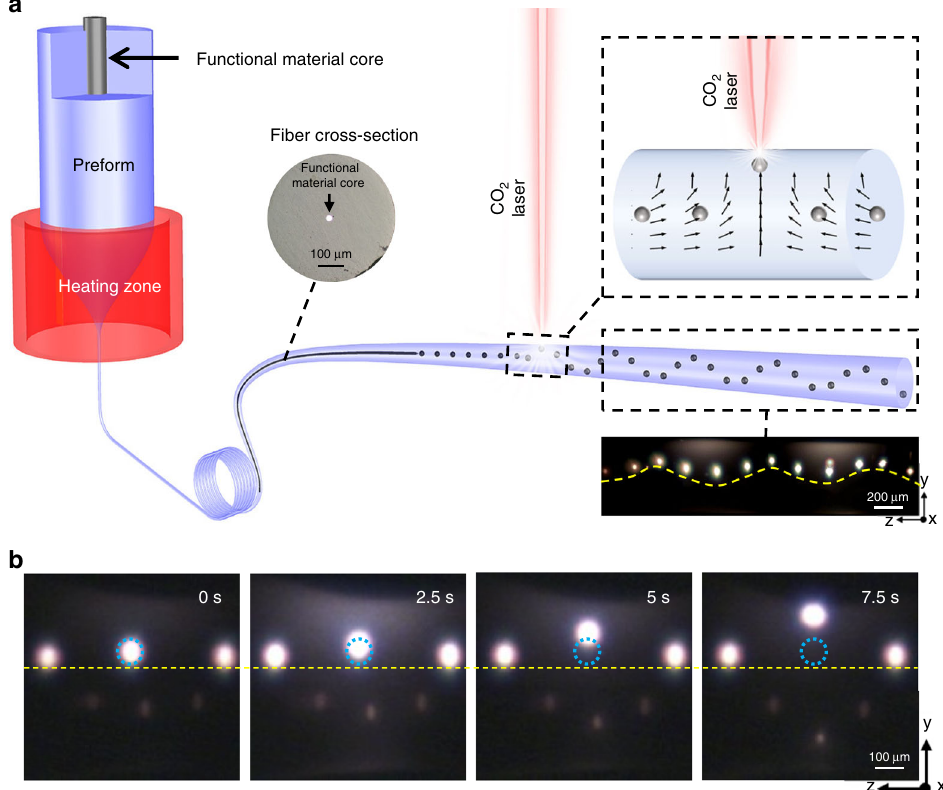
Fig. 1 CO 2 laser induced thermocapillary convection for in- fi bre particle manipulation and structure assembly. a Schematic of the multimaterial fi bre thermal drawing process and in- fi bre structure assembly based on CO 2 laser induced thermocapillary convection. The inset on the top right corner shows the velocity pro fi les of the convection fl ows which drag the particles. The inset on the right bottom corner shows a reconstructed germanium-in-silica fi bre with the germanium particles on a sinusoidal distribution. b Snapshots of an in- fi bre single particle with a diameter of 40 μ m guided and migrated by the CO 2 laser power at different time-points. At the beginning ( t = 0 s), the particle is located at the centre of the fi bre cladding. Starting from the laser switching on, the particle is dragged away from fi bre centre and migrated towards the cladding surface ( t = 7.5 s) where the laser is focused on. Blue circle indicates the original position when particle is